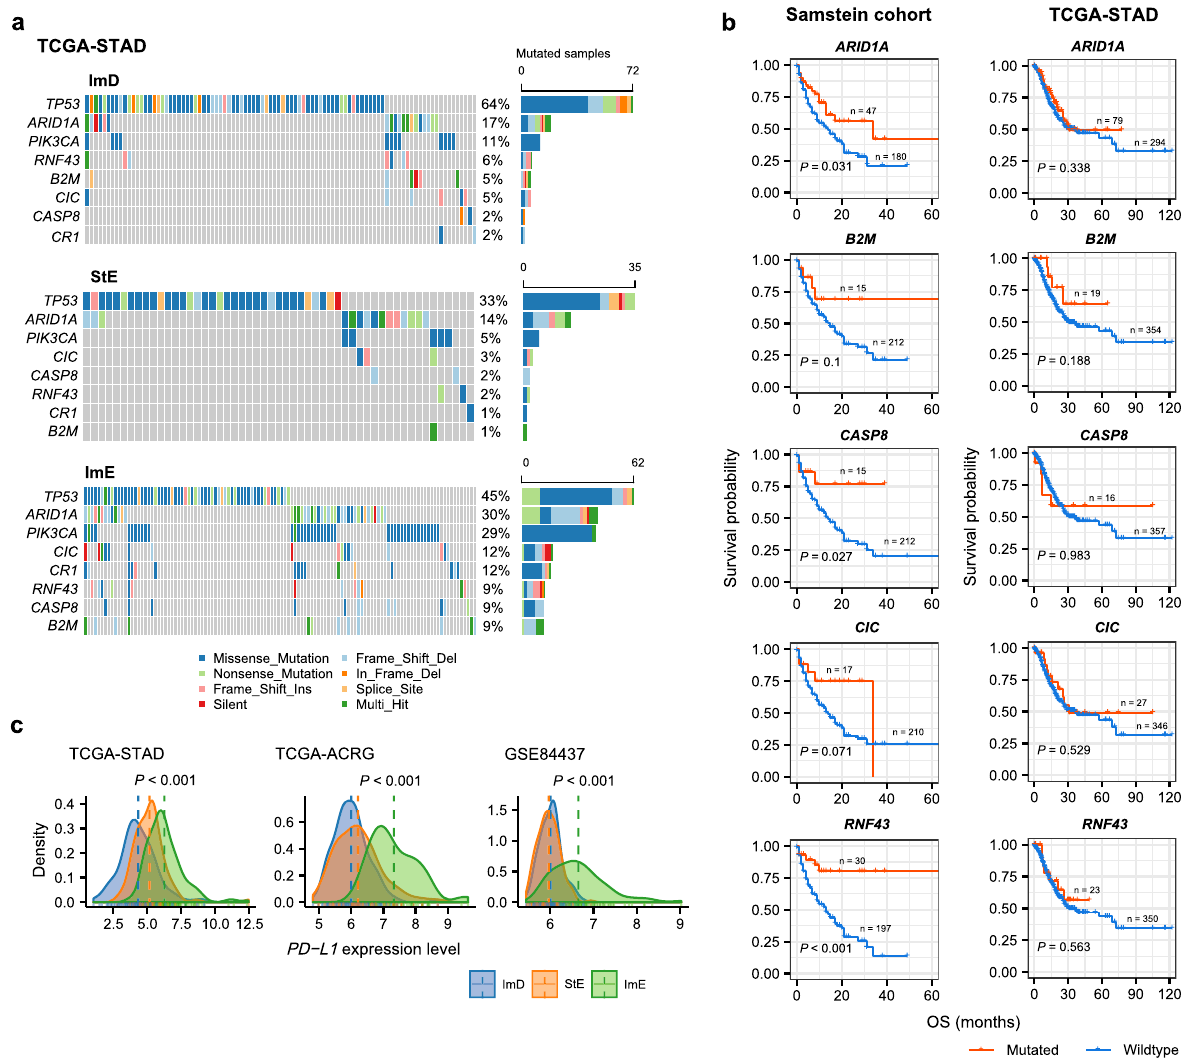
Fig. 4 Comparisons of mutation pro fi les between the three GC subtypes. a Eight genes showing signi fi cantly different mutation frequencies between the three GC subtypes in TCGA-STAD. b Five genes more frequently mutated in ImE than ImD and StE, whose mutations are correlated with better OS in the Samstein cohort (gastrointestinal cancer) 46 receiving immune checkpoint inhibitor treatment (log-rank test, P ≤ 0.1), but have no a signi fi cant correlation with OS in TCGA-STAD without such treatment. Kaplan – Meier curves are used to compare the survival time, and the log-rank test P values are shown. OS overall survival. c Comparisons of PD-L1 expression levels between the three GC subtypes. The one-way ANOVA test P values are